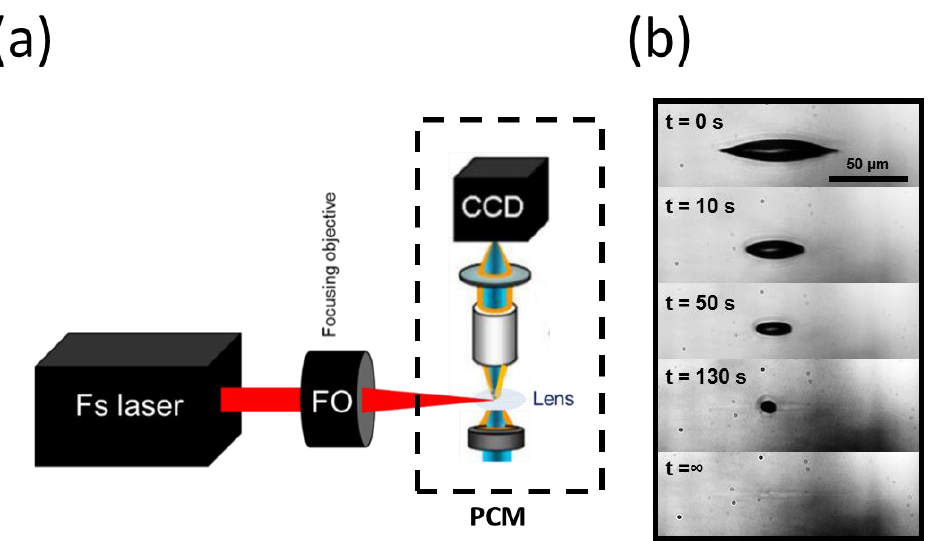
Figure 5. Time-resolved imaging device for real-time visualization of the cavitation. ( a ) Diagram showing the experimental setup for real-time visualization of the cavitation. The system was based on a conventional phase-contrast microscope (PCM), on which the femtosecond laser beam was focused onto the ex vivo pig lens. With fine adjustments, the irradiation zone was brought under the microscope’s field of view. A real-time video microscopy of the laser–tissue interaction was captured by a CCD camera with high spatial resolution and phase sensitivity (IXon, Andor Technology, Abingdon, UK). ( b ) A selection of real-time images acquired during the cavitation process in the lens. The time stamps are marked on the top-left of each image (with s for seconds). The bubble lifetime was about 130 s, after which a slight elongated trace persisted (enhanced contrast).